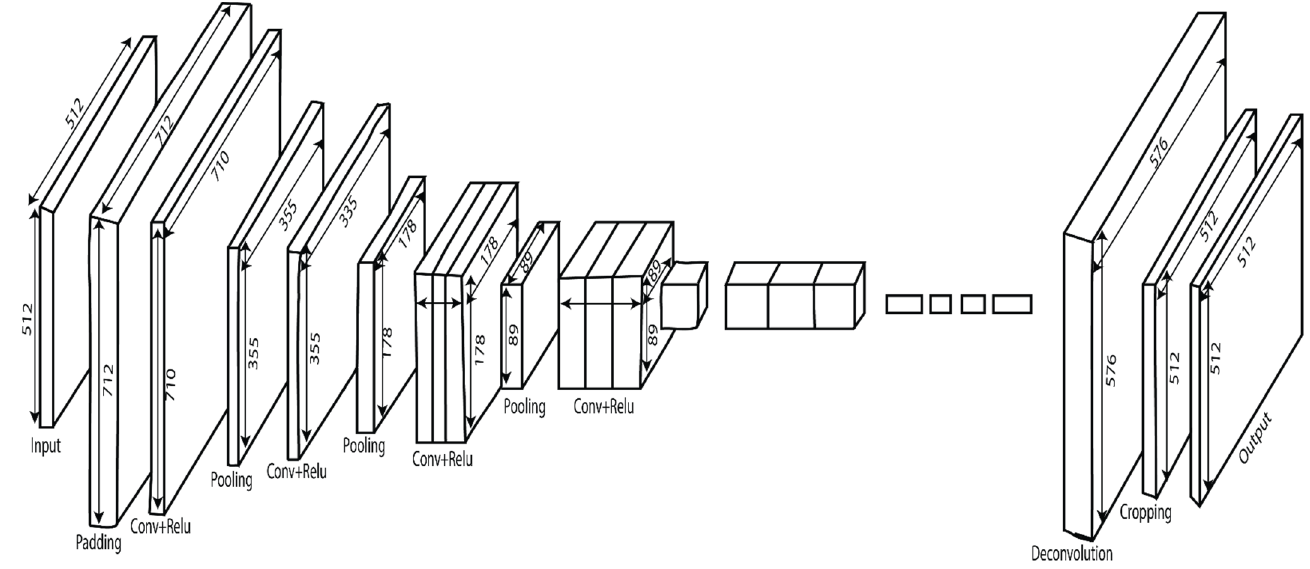
Figure 2. Proposed backbone VGG-16 architecture.